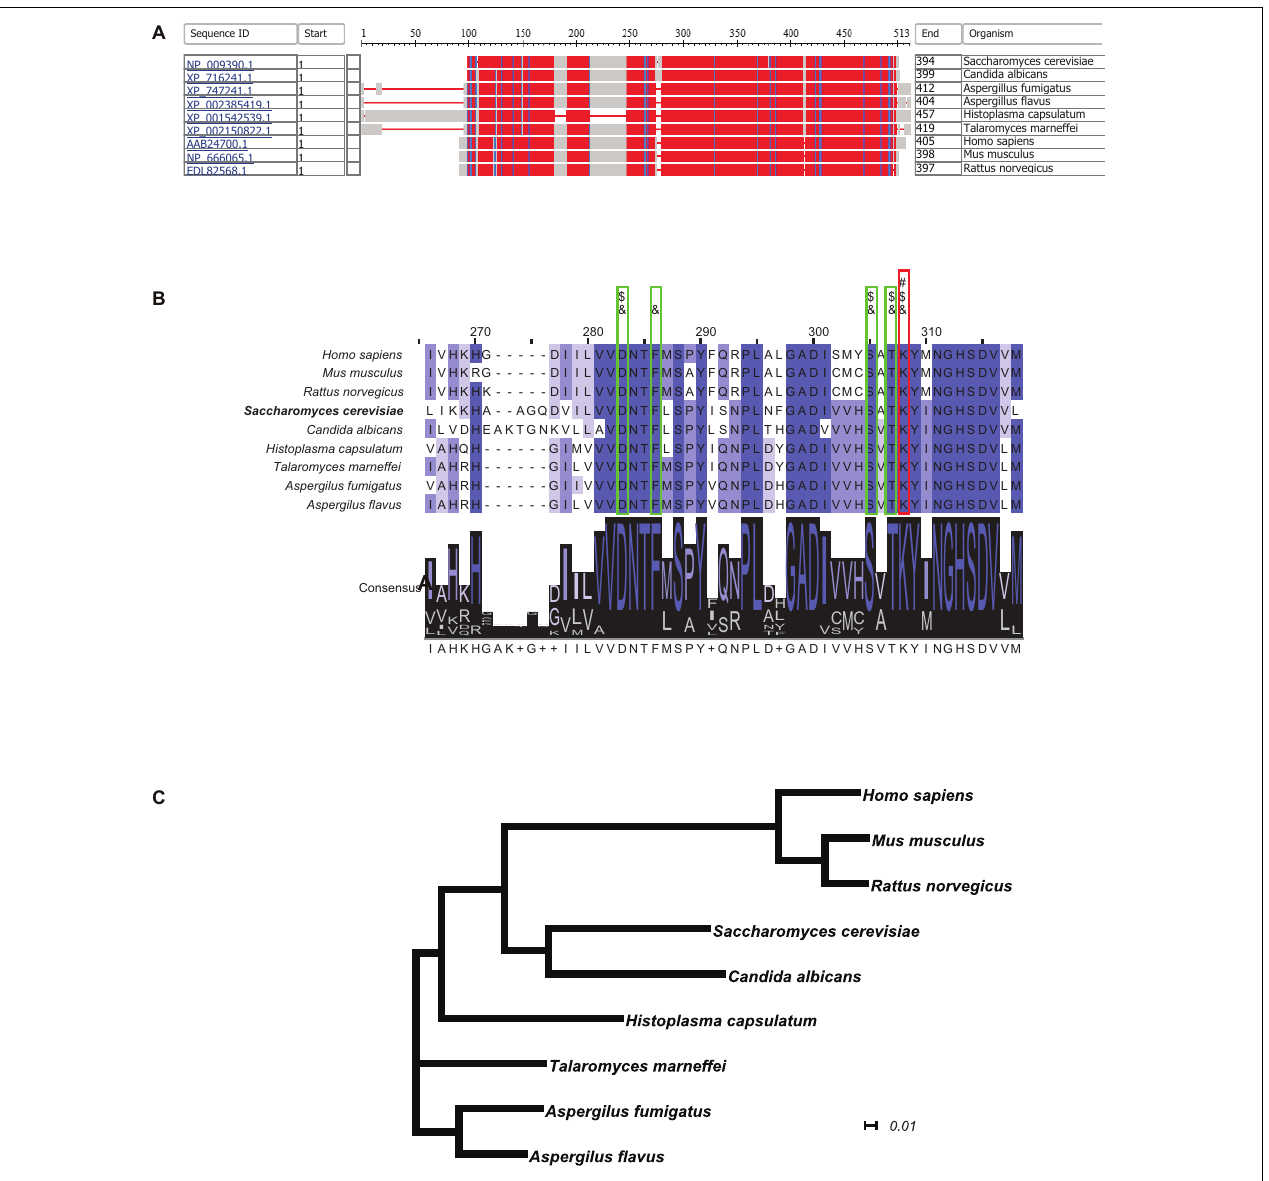
FIGURE 6 | Cystathionine- γ -lyase is a highly conserved enzyme throughout evolution. (A) The NCBI-COBALT (Constraint-based Multiple Alignment Tool) alignment display cystathionine- γ -lyase homologs from multiple species. The red parts show the highly conserved domains and the blue parts for less conserved domains, gray parts for no consensus of conservation. (B) The Conserved Protein Domain Family alignment revealed the key catalytic residues. The PID (Percentage Identity Color) codes for amino acid residue are as following: darkest cyan: the residues according to the percentage of the residues in each column that agree with the consensus sequence of a level of 80% or more; middle cyan between 60 and 80%; lightest cyan between 40 and 60%; no color when the consensus level below 40%. A “#” symbol represents a Schiff-base forming lysine residue at which PLP forms an internal aldimine bond. An “&” symbol represents an adjacent residue forming a hydrogen bond with the phosphate group of PLP for anchoring. A “$” symbol represents an adjacent residue involved in substrate-cofactor accommodation. (C) The phylogenetic analysis showed the evolutionary conservatism of the cystathionine- γ -lyase among the 12 species. The plotting scale shows the evolutionary distance of 0.1 K nuc